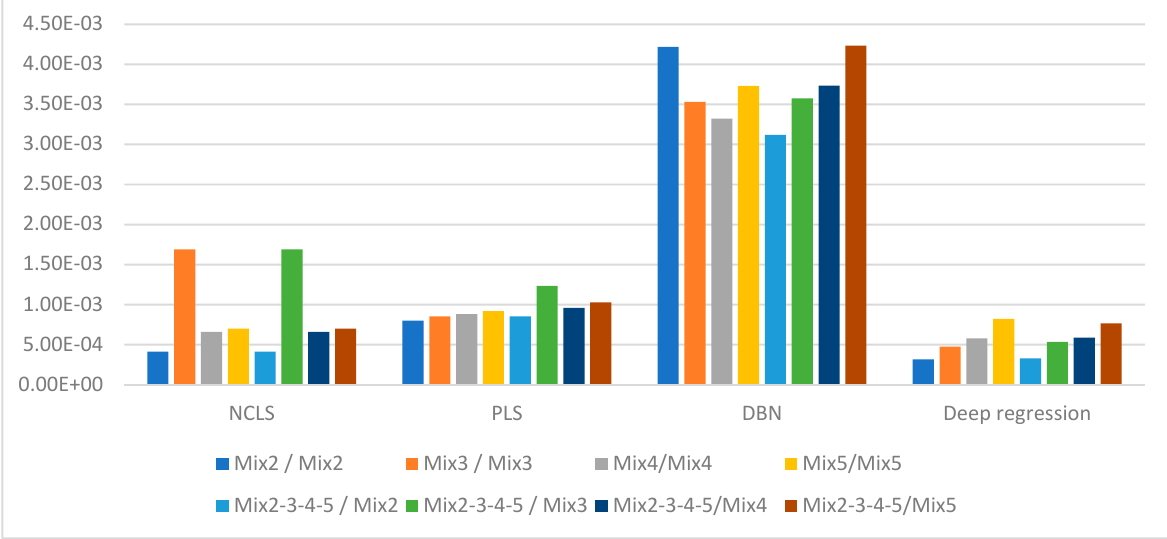
Figure 11. Average RMSE comparison using bar plots for “low ‐ mixing ‐ rate mixture” dataset with respect to method (Mix ‐ ing ‐ rate range used for synthesizing mixtures is: [10 − 3 10 − 1 ], Min: 10 − 3 Max: 10 − 1 ).